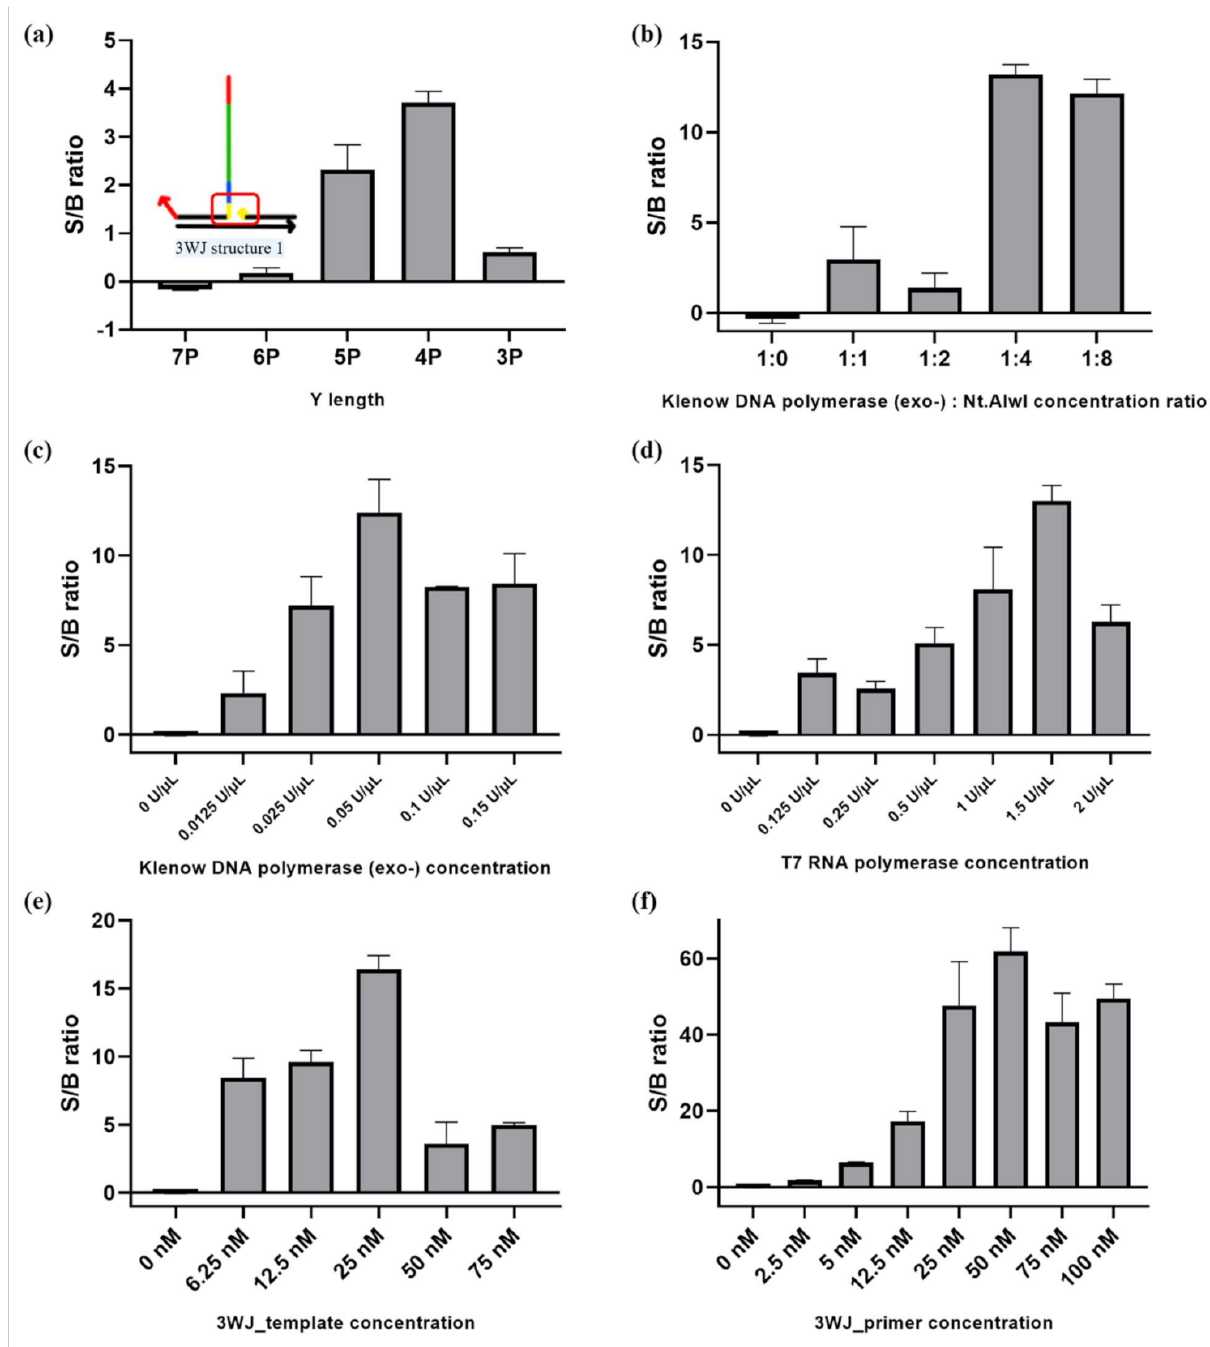
Figure 4. Optimization of 3WJ-induced transcription amplification. ( a ) The effect of complementary sequence (Y) length between 3WJ_primer and 3WJ_template. ( b ) Optimization of the Klenow DNA polymerase (exo-) and Nt.AlwI ratio. ( c ) Optimization of Klenow DNA polymerase (exo-) concentration. The Klenow DNA polymerase (exo-) and Nt.AlwI ratio is 1:4. ( d ) Optimization of T7 RNA polymerase concentration. ( e ) Optimization of 3WJ_template concentration. ( f ) Optimization of 3WJ_primer concentration. The concentration of the target nucleic acids is 10 nM. All experiments were performed in